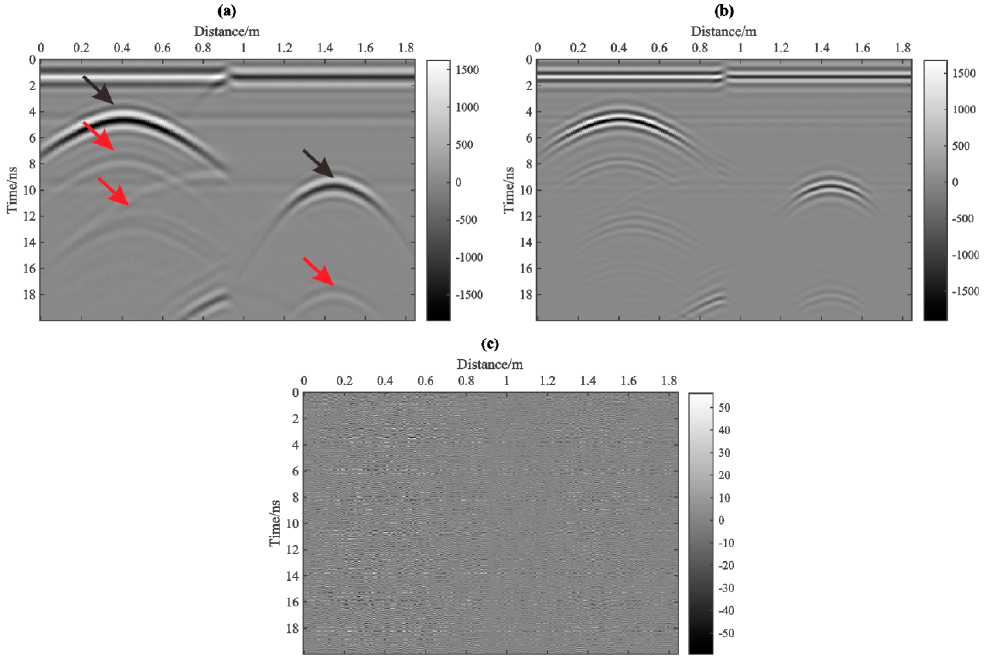
Figure 8. IMF-slices of the GPR simulation model using MVMD. ( a − c ) show the IMF-slices 1 − 3, re- spectively.